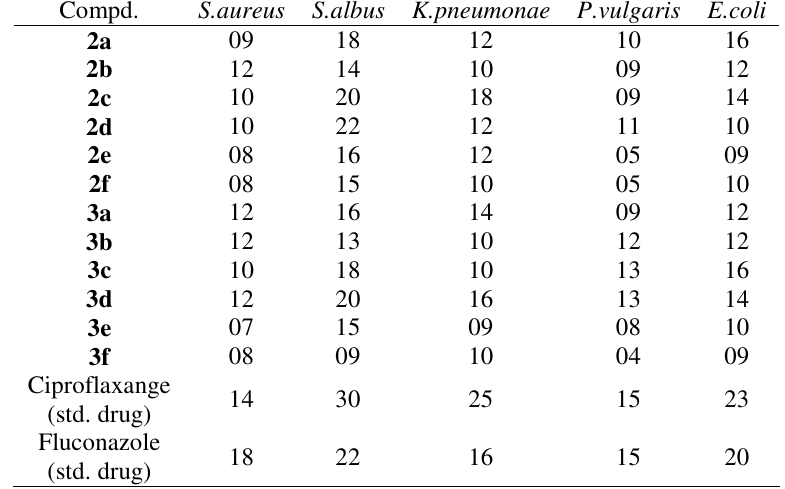
Table 2. Biological screening results of compounds ( 2 ) & ( 3 ) zone of inhibition in mm.